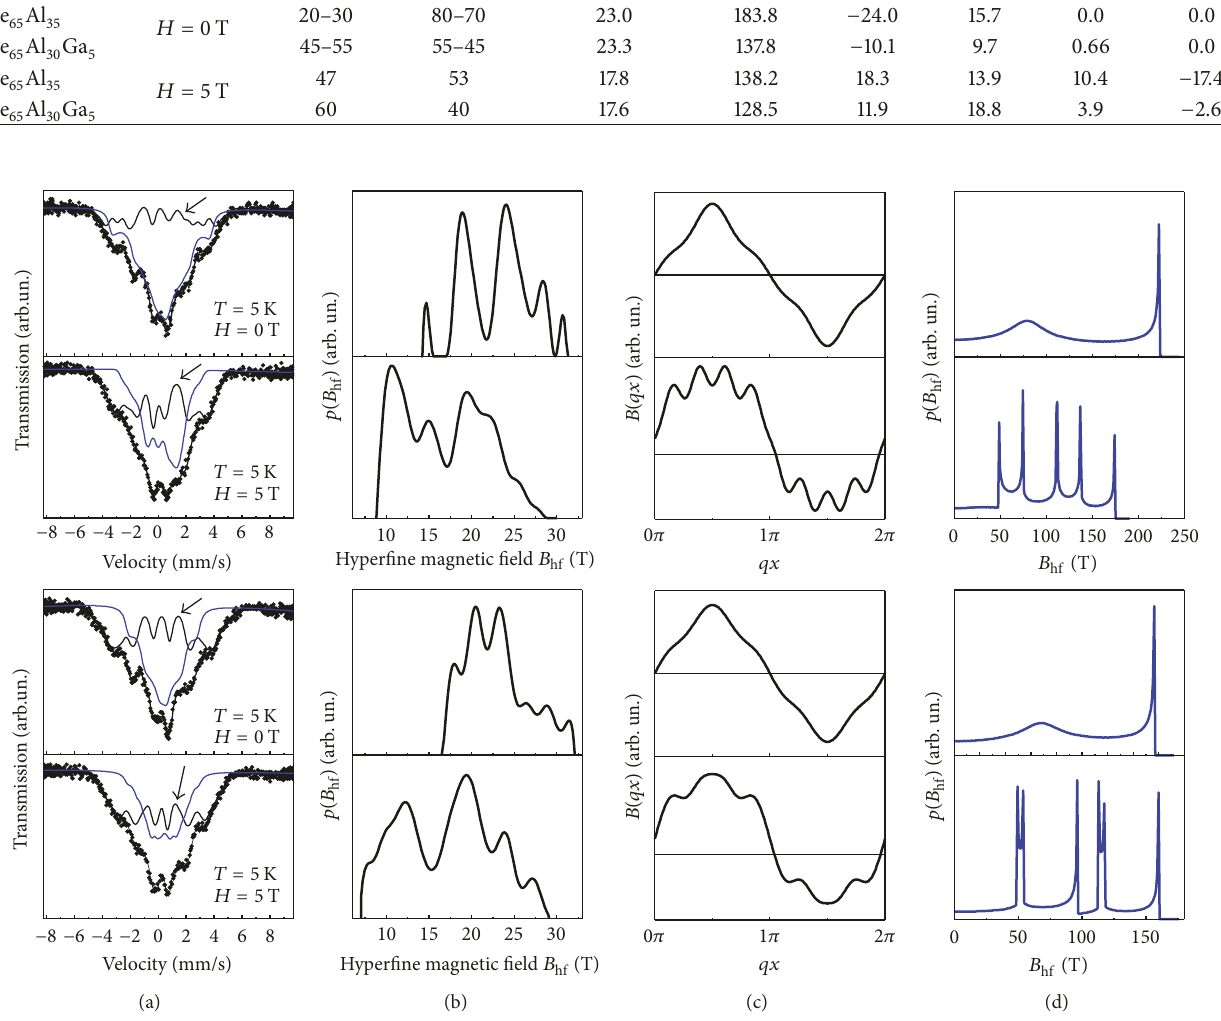
Figure 4: (a) M¨ossbauer spectra measured without external field and in an applied external magnetic field 𝐻 ext = 5T for the alloys Fe 65 Al 35 and Fe 65 Al 30 Ga 5 . The spectrum components corresponding to the subsystems of the ferromagnetic type (black colour, shown by the arrow) and of the SDW (blue color) are presented, as well as the resulting spectrum envelope; (b) the HFF distributions of the ferromagnetic-type component; (c) the shape of the spin density wave; (d) the HFF distribution resulting from the SDW